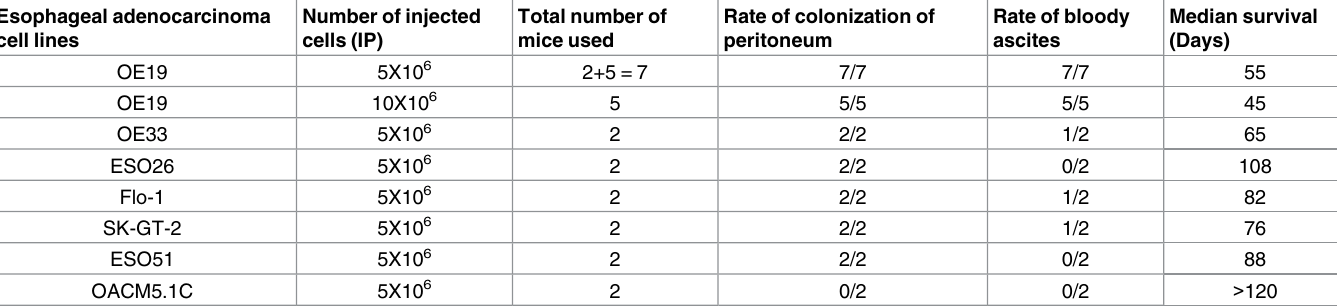
Table 2. Metastasisand survival outcome after intraperitoneal (IP) inoculation of esophageal adenocarcinoma cell lines.